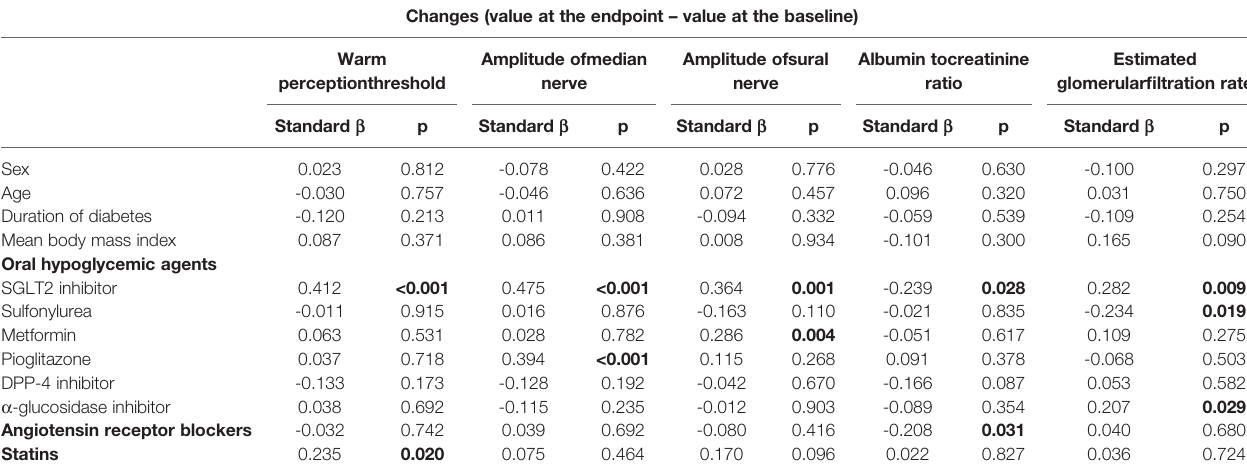
TABLE 4 | Correlations between the changes in warm perception threshold, amplitude of median and sural nerve, albumin to creatinine ratio or estimated glomerular fi ltration rate and the use of various oral hypoglycemic agents, angiotensin receptor blockers or statins at the endpoint or clinical covariates in total type 2 diabetic patients treated with or without sodium-glucose cotransporter-2